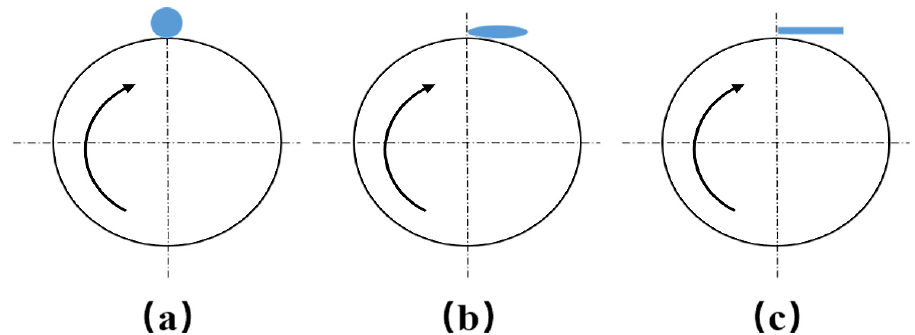
Figure 2. Planar diagram of the simplified fiberization process: ( a ) The moment of the fixed vis- cous fluid falling downward onto the spinning wheel; ( b ) Droplet stretch stage; ( c ) Droplet final filament stage.